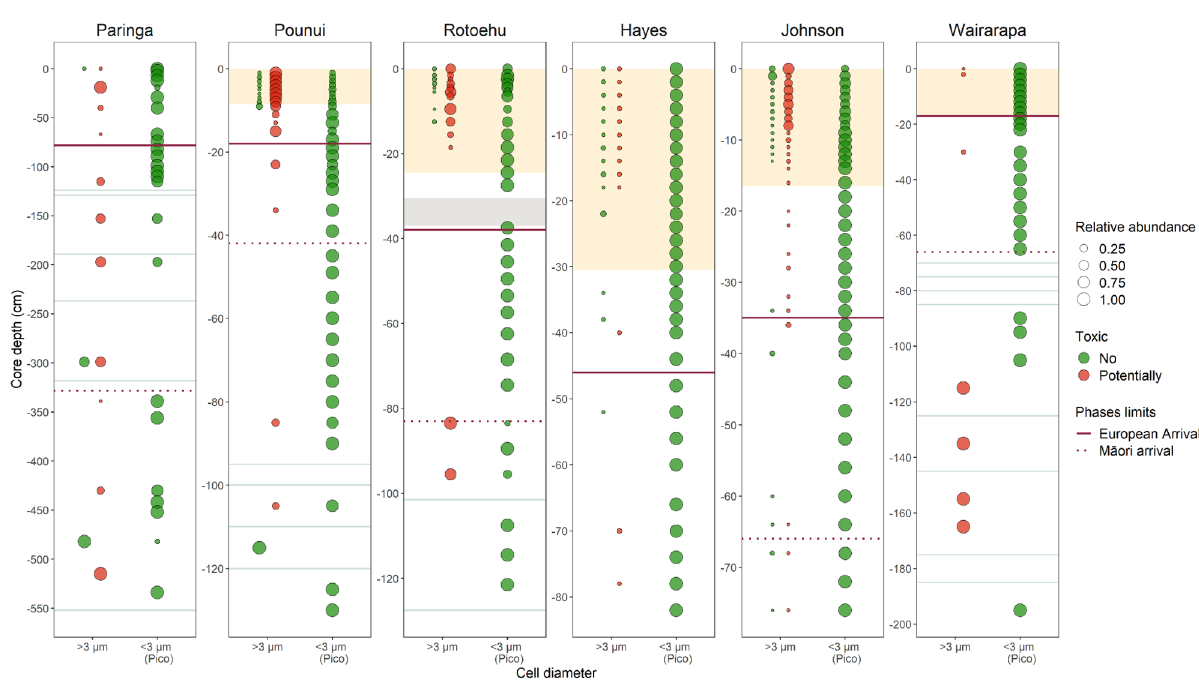
Figure 6. Relative abundance profiles of photosynthetic cyanobacterial genera classified by size (> 3 µm or < 3 µm—picocyanobacteria) and potential toxin production. Relative abundance is plotted as a continuous variable and the legend gives an indication of size for a set of abundances. Potential for toxin production of each genus was inferred from the literature. Phase delimitation is indicated by horizontal purple straight and purple dotted lines (see legend). Horizontal grey lines indicate samples with no cyanobacteria sequences after rarefaction. Yellow shades indicate land-use intensification in relevant lakes. Grey shade in the Lake Rotoehu core indicates the Tarawera tephra